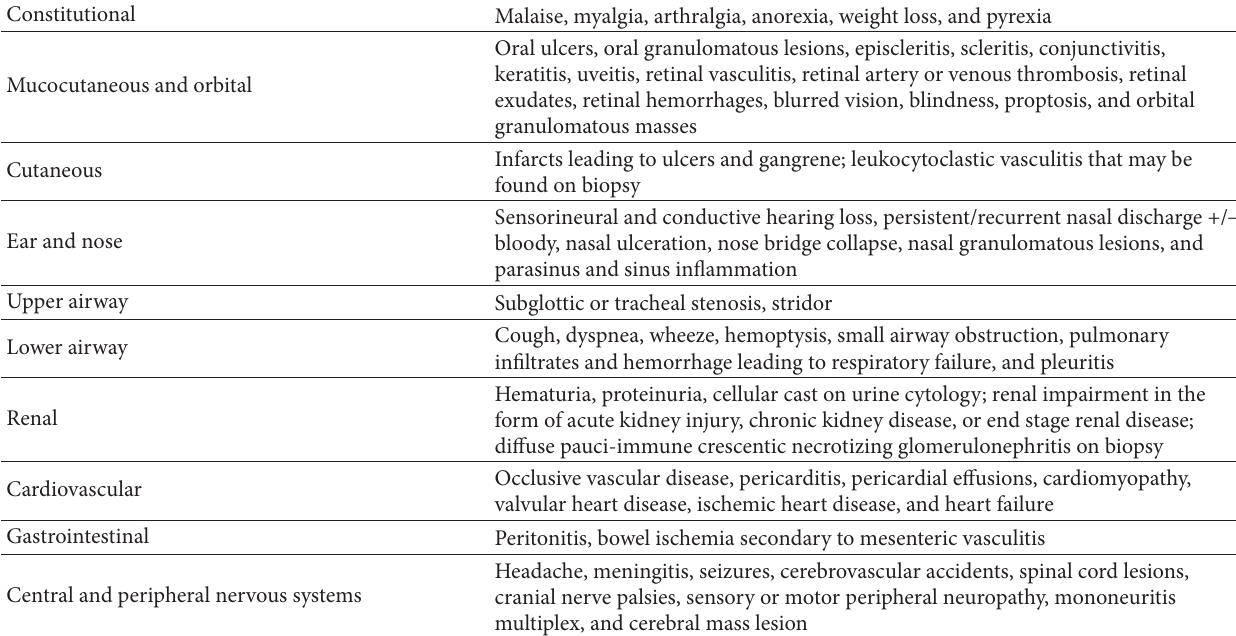
Table 1: Organ-based clinical features of granulomatosis with polyangiitis.